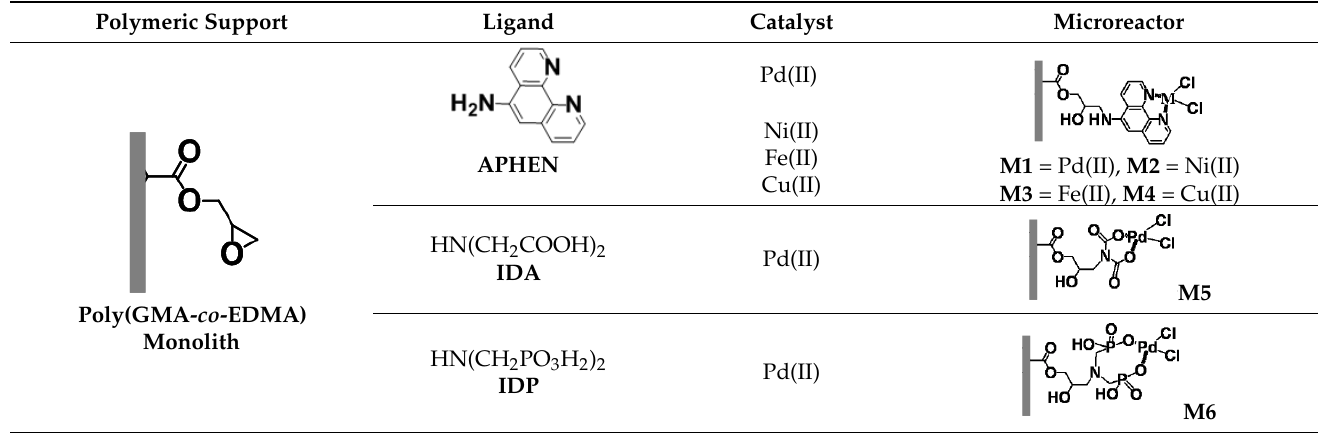
Table 1. Metal-immobilized Poly(GMA- co -EDMA)-based monolithic flow-through microreactors. Polymeric Support